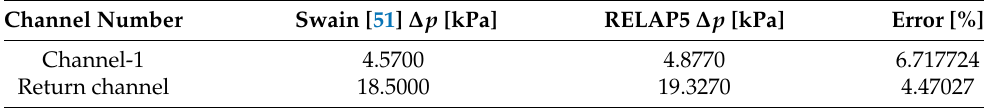
Table 11. Pressure drop differences in counterflow electro-coupled conduits ( B = 4